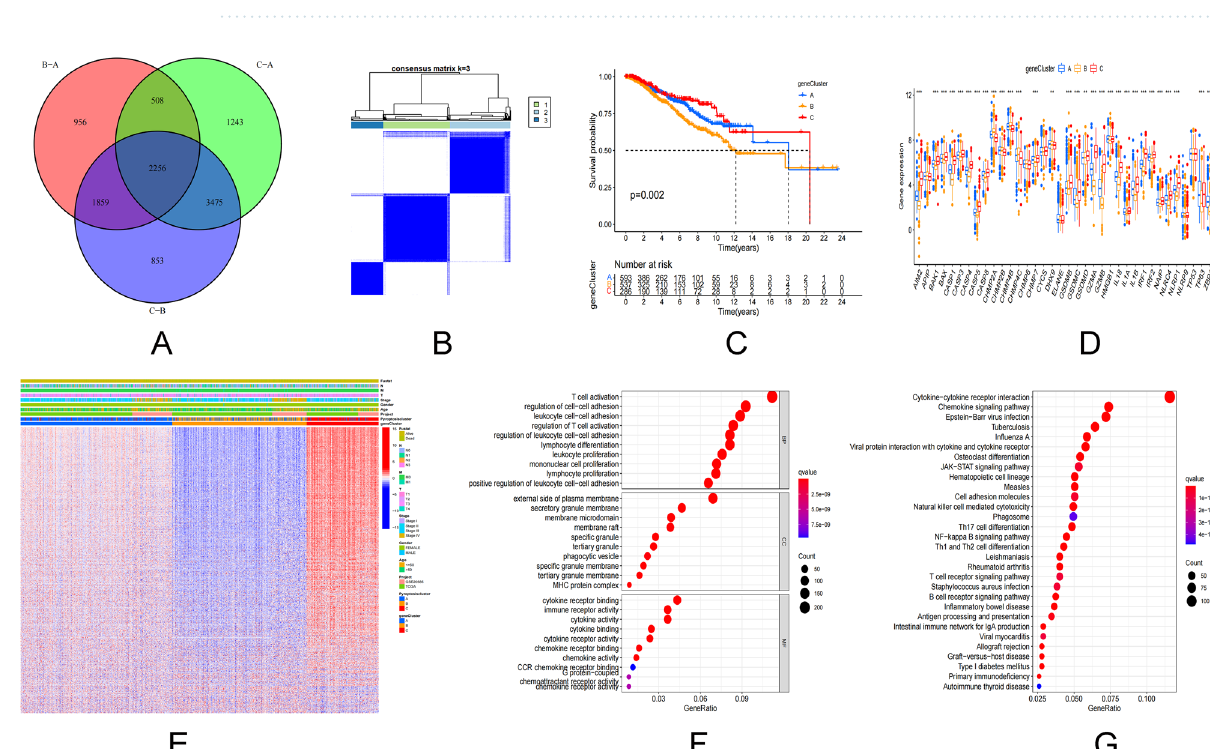
Figure 3. Gene subtypes based on PRGs. ( A ) Venn diagram showing DEGs for the three pyroptosis subtypes. ( B ) Consensus matrix heat map defining the three genetic subtypes subtypes (k = 3). ( C ) Survival analysis of the three genetic subtypes versus overall survival. ( D ) Expression distribution of the 40 PRGs in the three genetic subtypes. ( E ) Differences in expression levels of the three genetic subtypes in relation to clinicopathological features and PRGs. ( F,G ) GO and KEGG enrichment analysis of DEGs in the three genetic